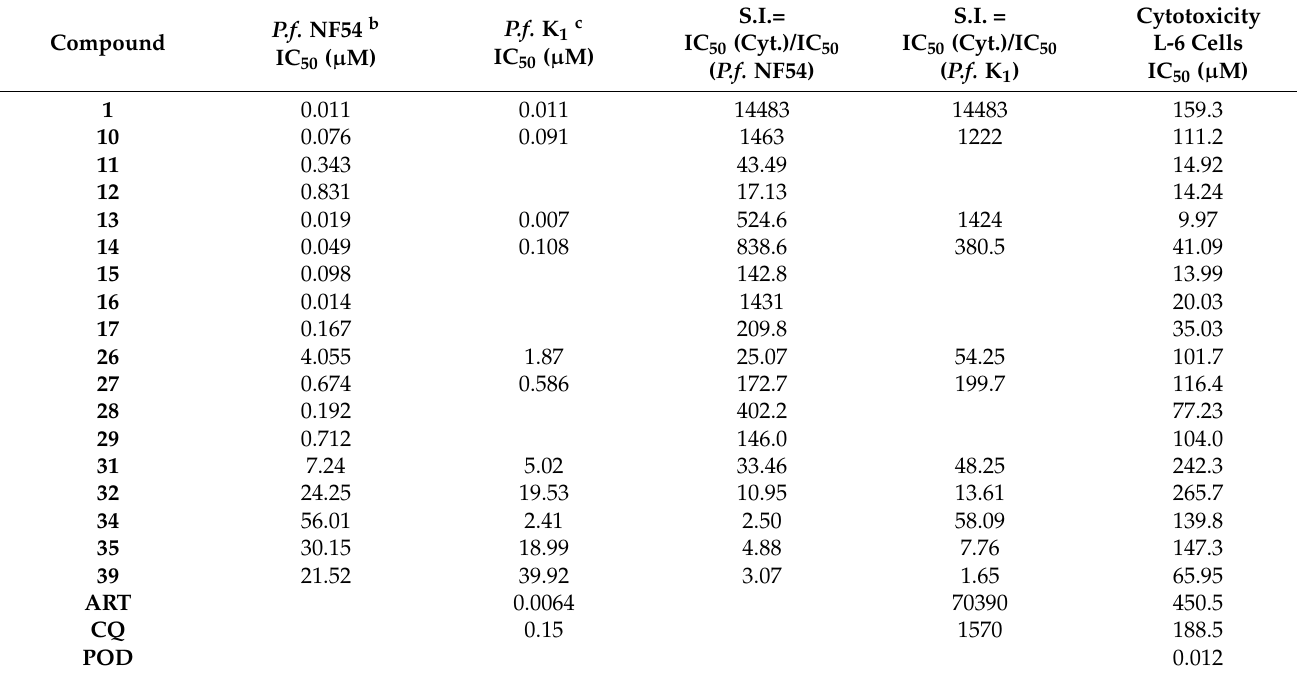
Table 1. Activities of compounds 1 , 10 – 17 , 26 – 29 , 31 , 32 , 34 , 35 and 39 against P. falciparum NF54, P. falciparum K 1 and L-6 cells, expressed as IC 50 ( µ M) a